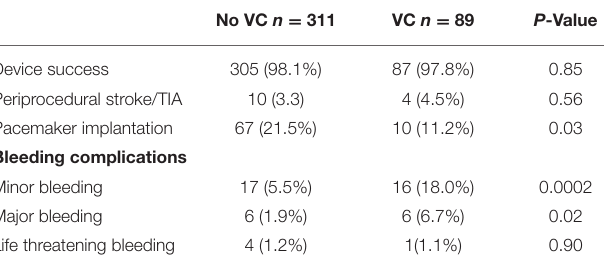
TABLE 4 | Procedural